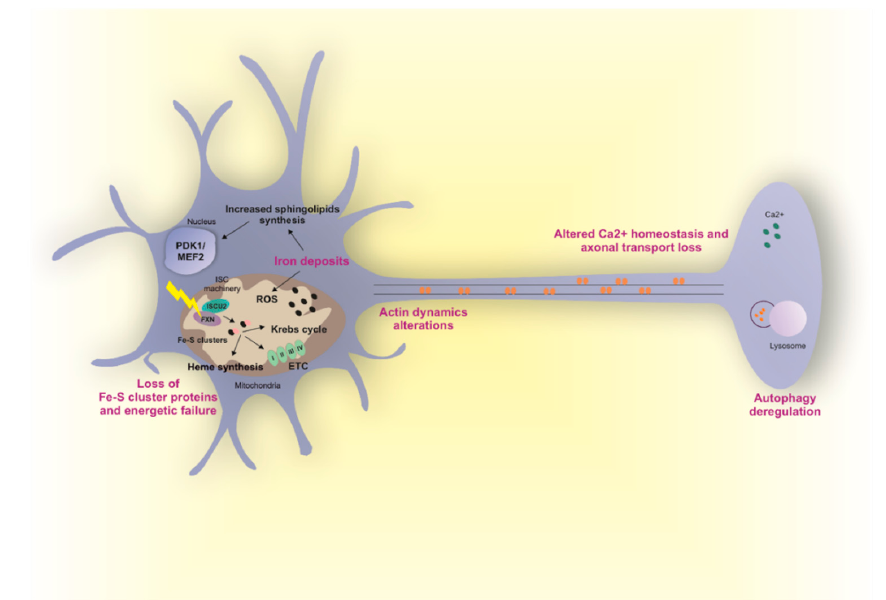
Figure 2. Altered molecular mechanisms in FRDA affected neurons . Frataxin (FXN) deficiency in FRDA results in the degeneration of specific neuron types leading to the ataxia phenotype. Different